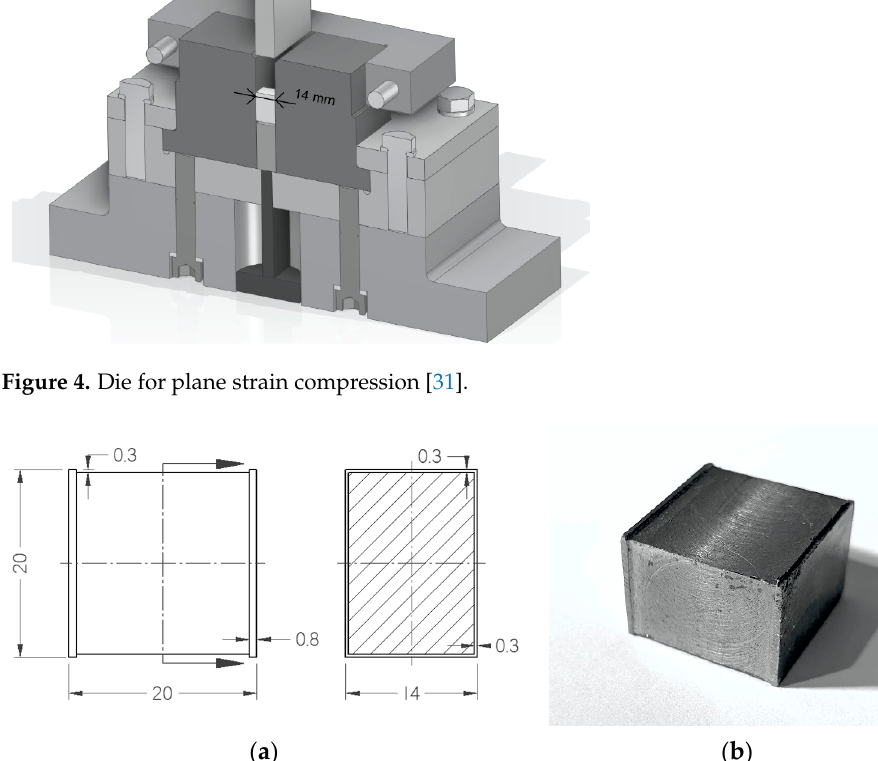
Figure 5. Schematic diagram of the specimens ( a ) and a specimen image ( b ).